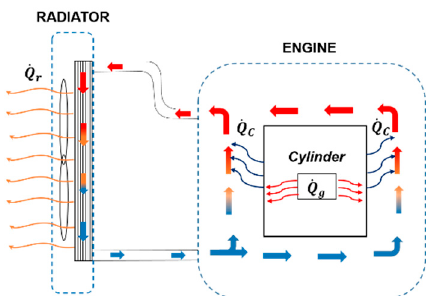
Figure 1. Thermal energy fluxes between the in-cylinder gases and the wall ( Q (cid:4662) ) and between the coolant and atmosphere ( Q (cid:4662) and the coolant ( Q (cid:4662) C